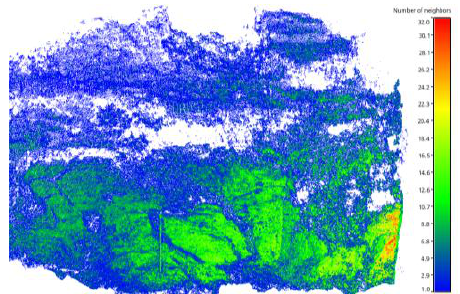
Figure 4. Number of neighbours within a sphere of 1 cm radius for each point as in Figure 3. Rock surfaces show a higher density (greens to red) than vegetated areas